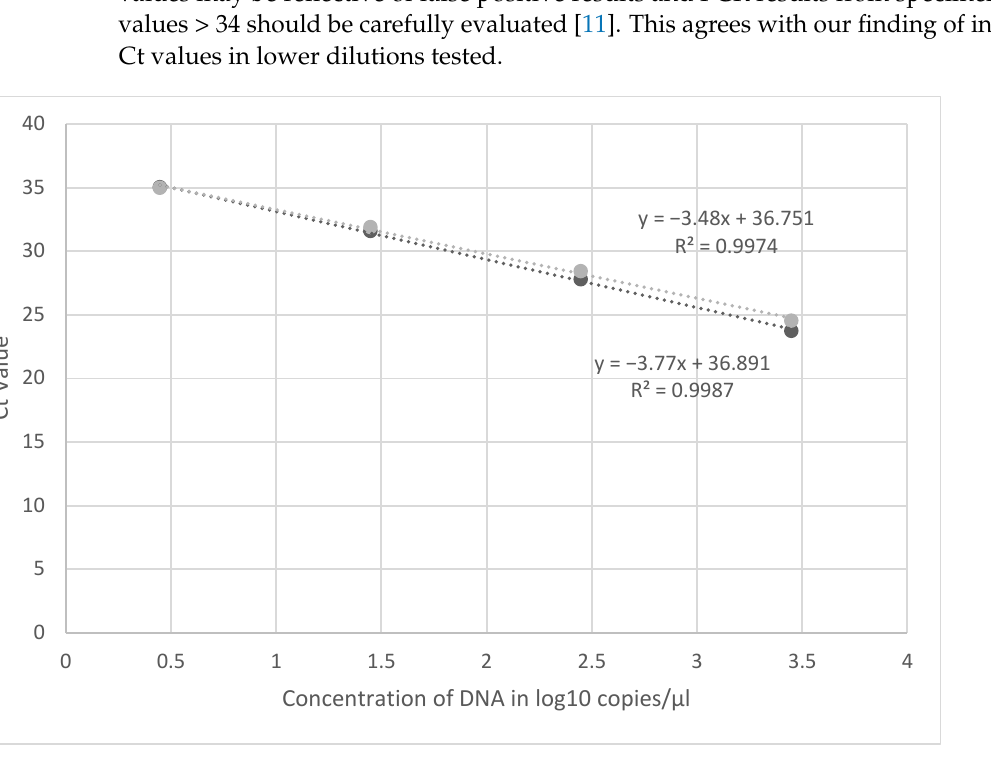
Figure 1. Linearity of the primer probe set (D9-5 and D9-6) using dilutions of synthetic MPXV DNA. Experiments were run in duplicate, mean Ct value was used for linearity.